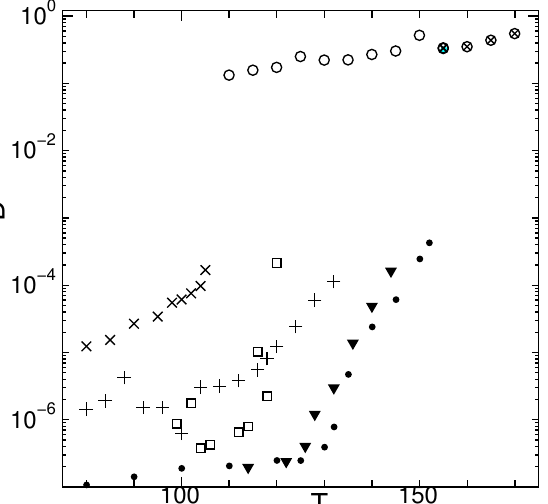
Figure 1. Temperature dependence of diffusion coefficient of states G ( ▼ ), J ( ◻ ), M ( × ), O ( + ), and crystal ( ● ), with that of supercooled liquid ( ○ ) and thermodynamic equilibrium liquid ( ⊗ ) for system size N = 5376.